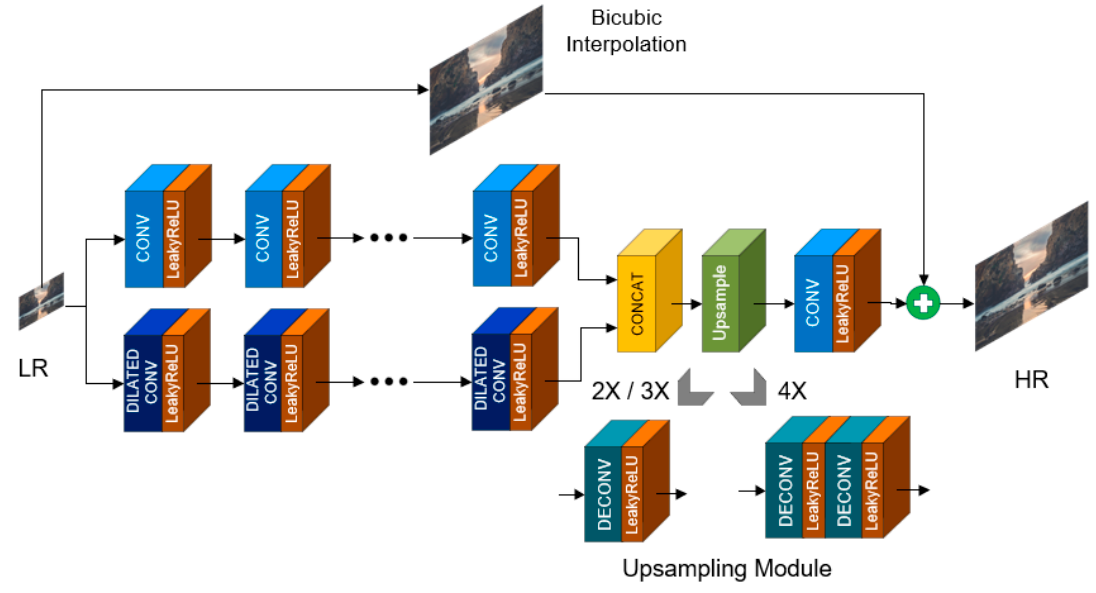
Figure 19. DBCN network structure.